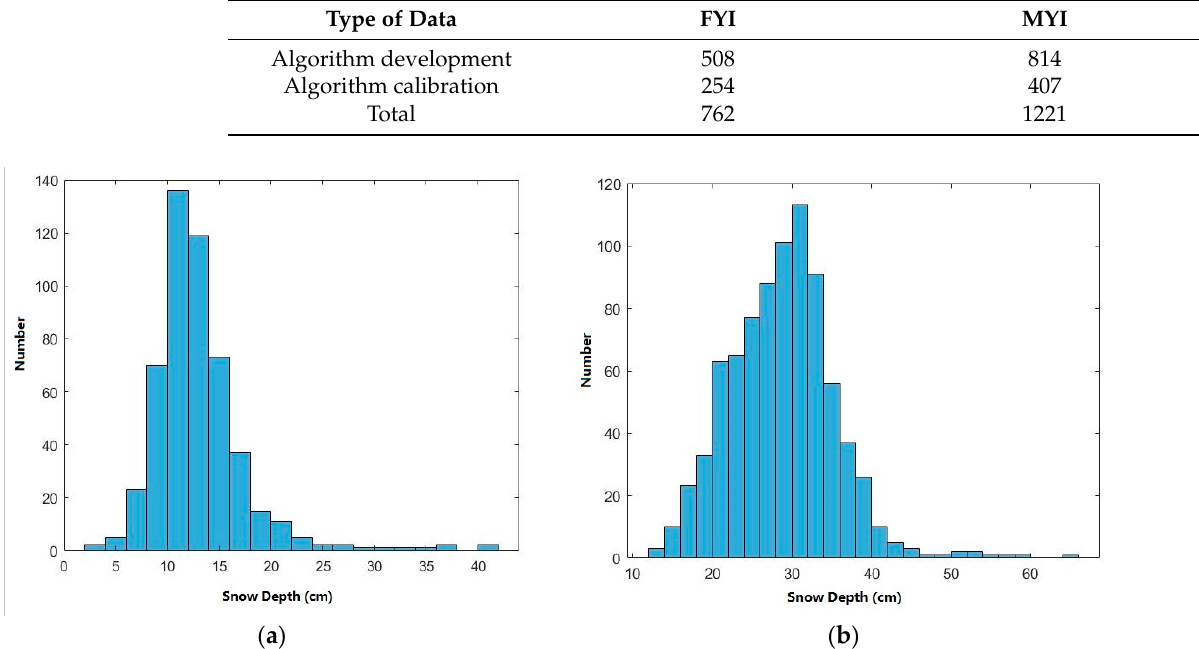
Figure 7. Histogram of snow depths for algorithm development. ( a ) FYI; ( b ) MYI.